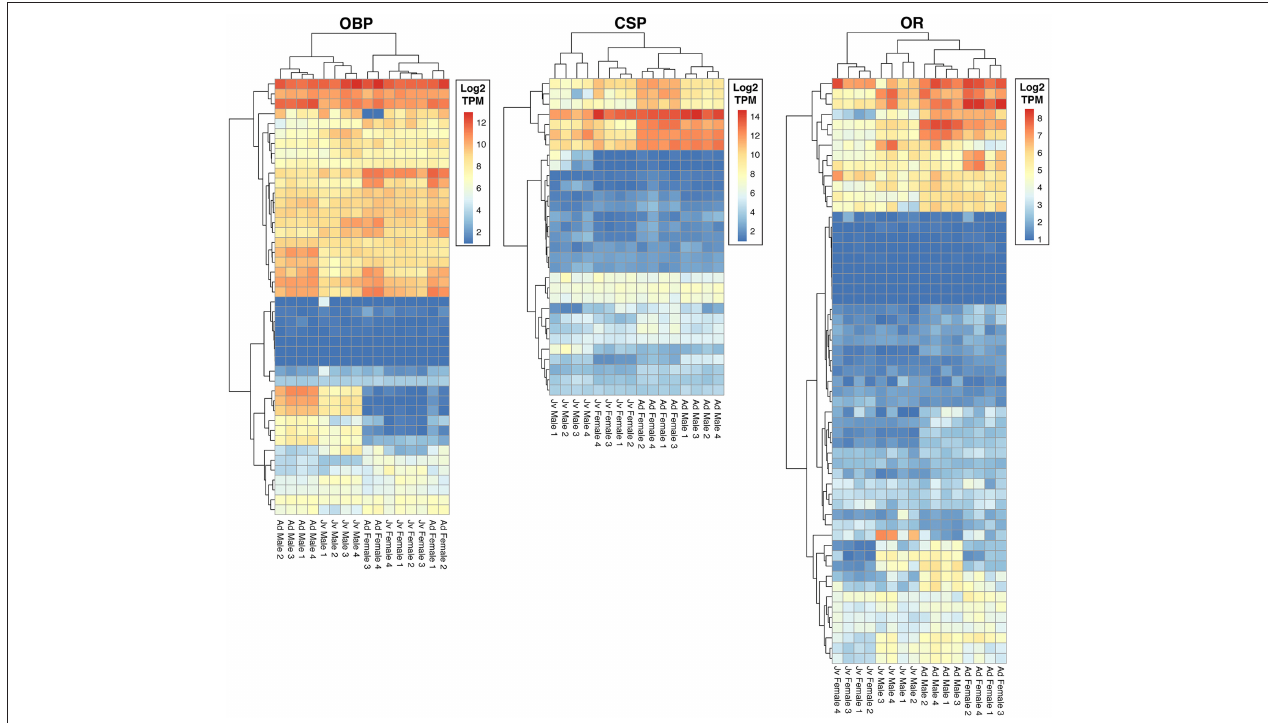
FIGURE 1 | Heatmaps of expression of olfactory genes in antennae of juvenile and adult males and females of Timema cristinae . OBP, odorant binding proteins; CSP, chemosensory proteins; OR, odorant receptors. Jv, Juvenile; Ad, Adult.